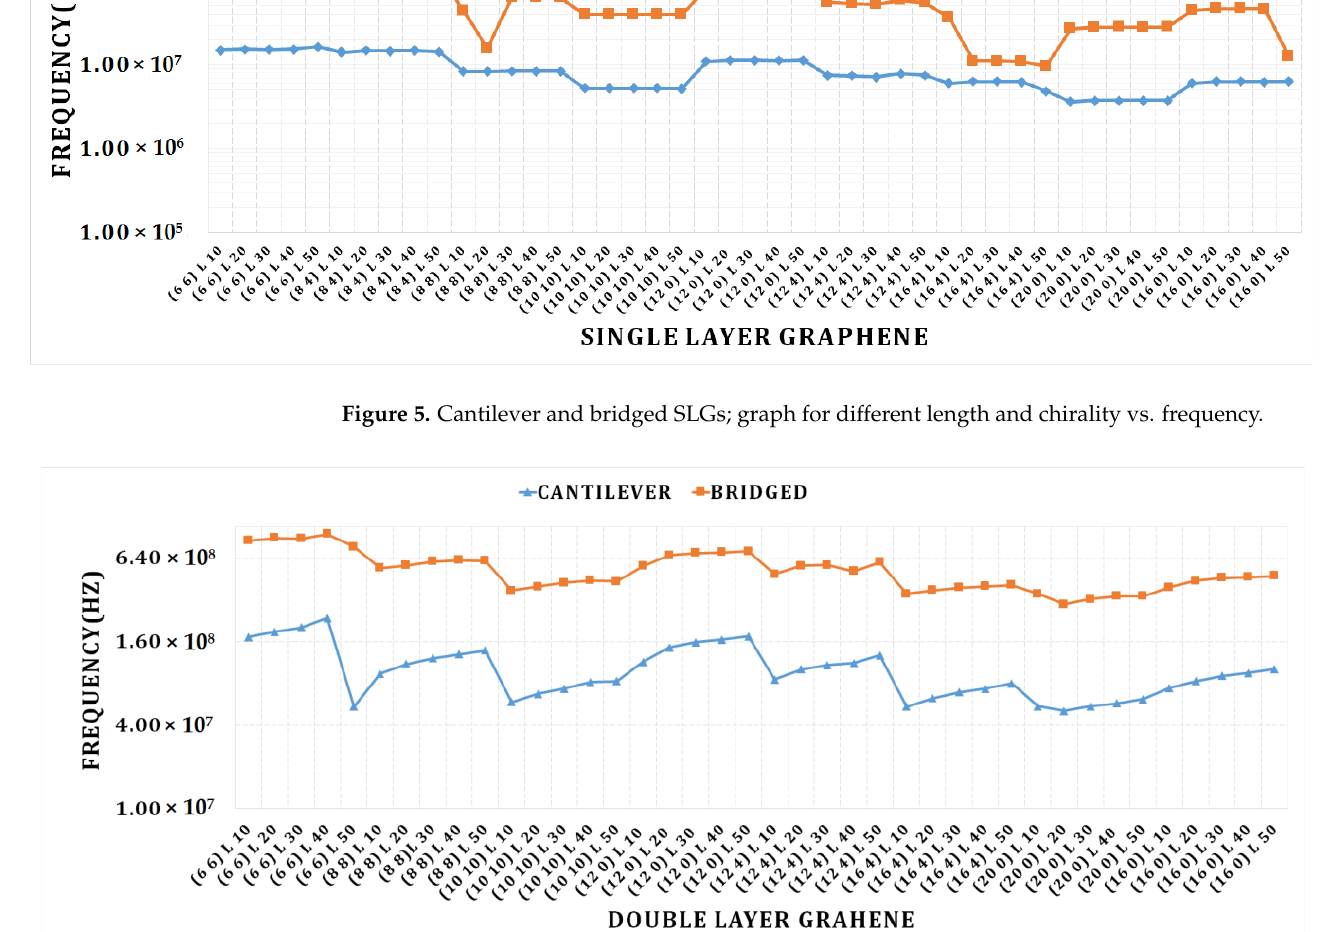
Figure 5. Cantilever and bridged SLGs; graph for different length and chirality vs. frequency.